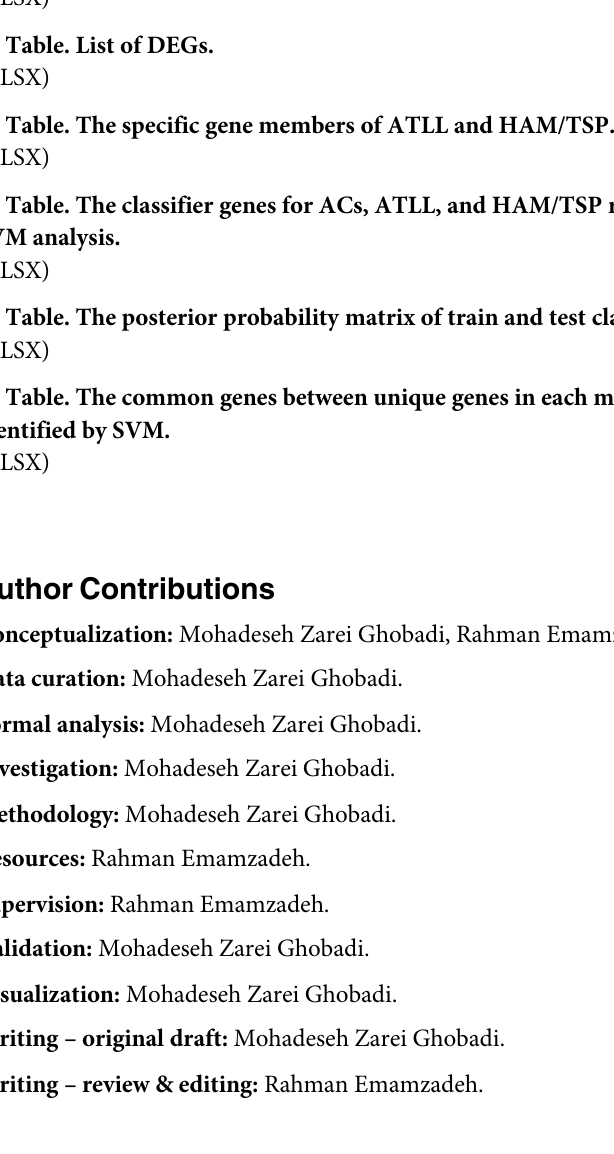
S1 Table. The common interaction between correlated genes in modules and the interacted genes at the protein level. S2 Table. List of DEGs. S3 Table. The specific gene members of ATLL and HAM/TSP. S4 Table. The classifier genes for ACs, ATLL, and HAM/TSP resulted from multi-class SVM analysis. S5 Table. The posterior probability matrix of train and test classes. S6 Table. The common genes between unique genes in each module and classifier genes identified by